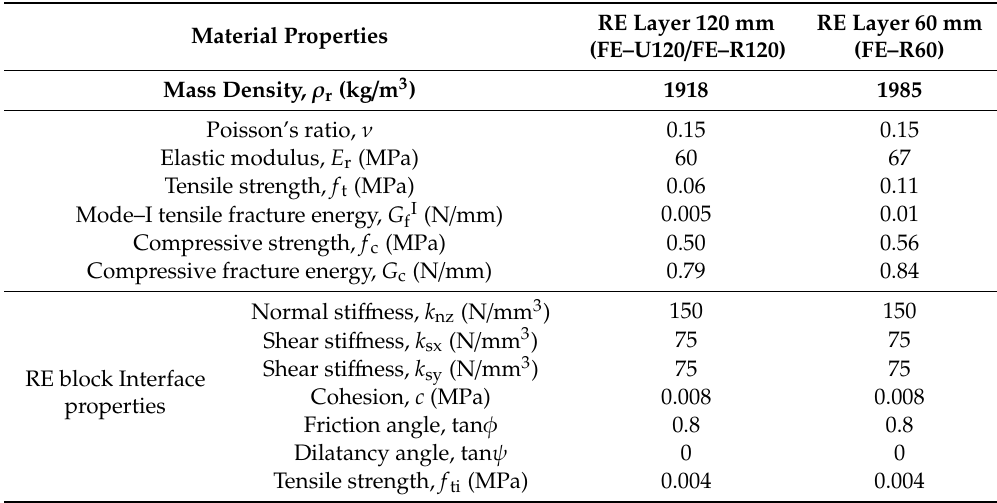
Table 2. Material properties of RE element and RE block interface element adopted in the finite element (FE)